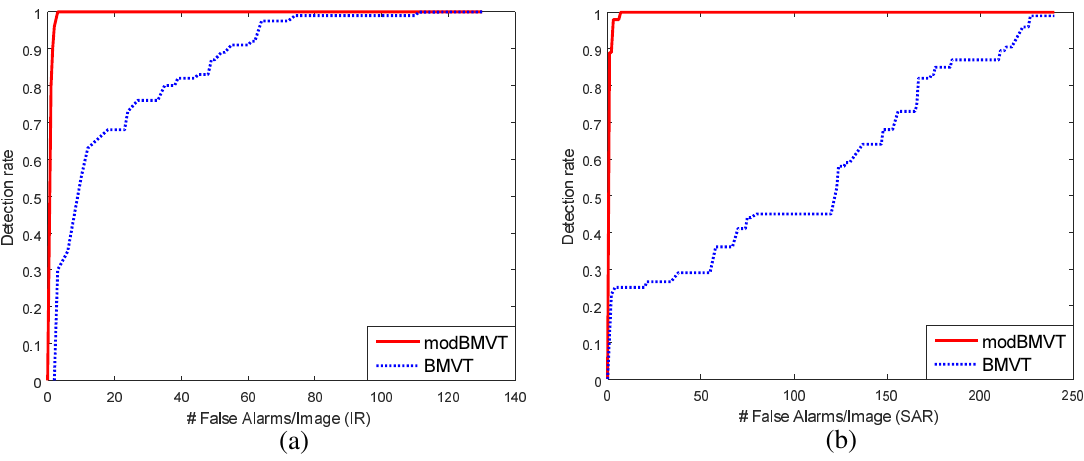
Figure 23. Performance evaluation of the individual target detection of the proposed modBMVT compared to the original BMVT: ( a ) ROC comparison for the IR test image of BG1-T10-IR; ( b ) ROC comparison for the SAR test image of